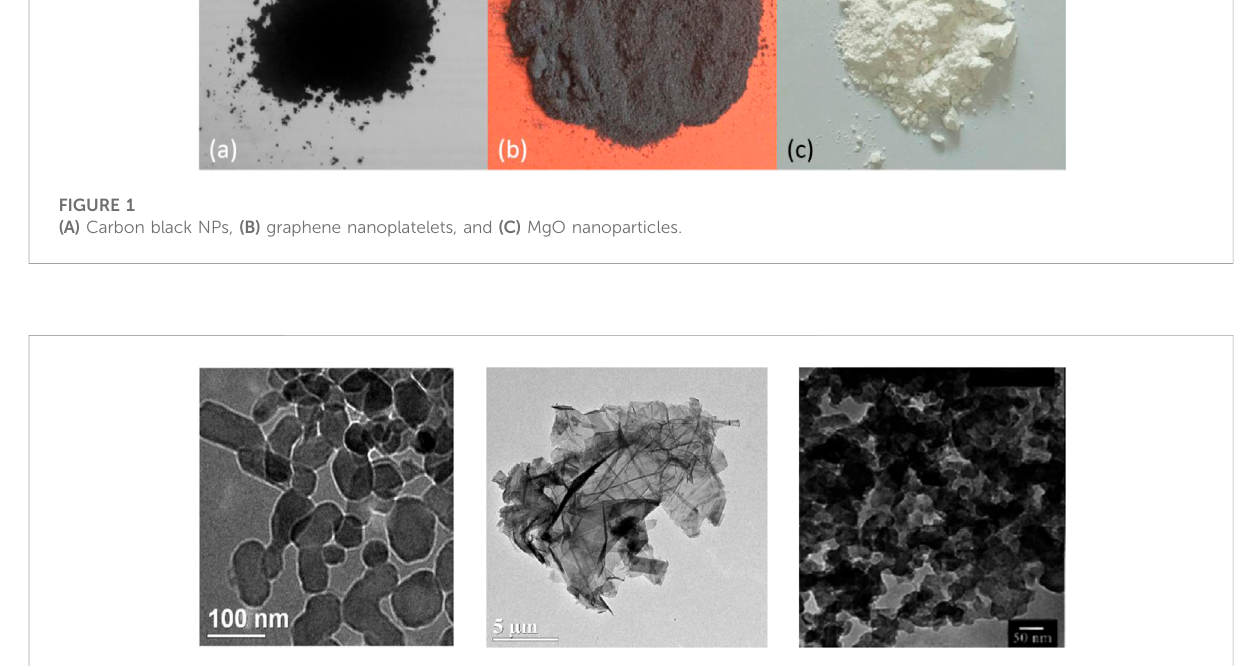
FIGURE 2 TEM image of MgO (left), graphene nanoplatelets (middle), and carbon black (right) (Courtesy: Nanostructured and Amorphous Materials, Inc., Houston, United States; Advanced Chemical Supplier Material LLC, Pasadena, CA, United